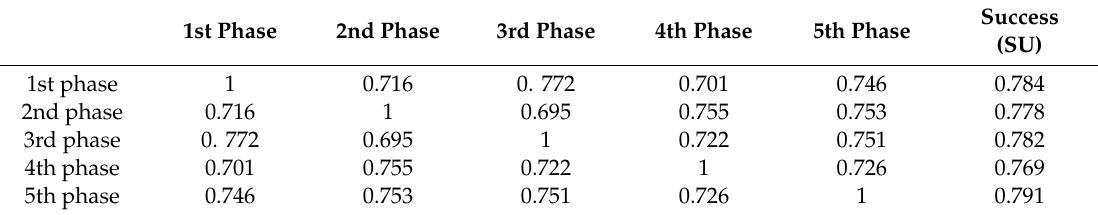
Table 4. Correlation matrix.